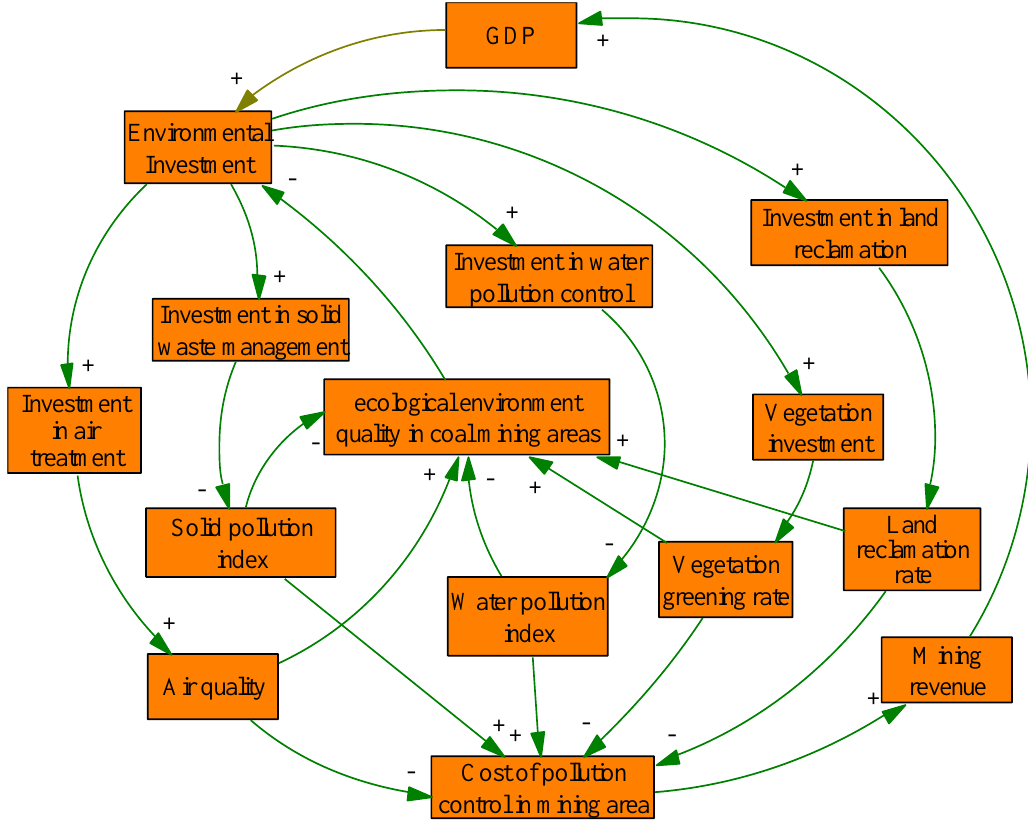
Figure 1. The whole causal loop diagram of the system.